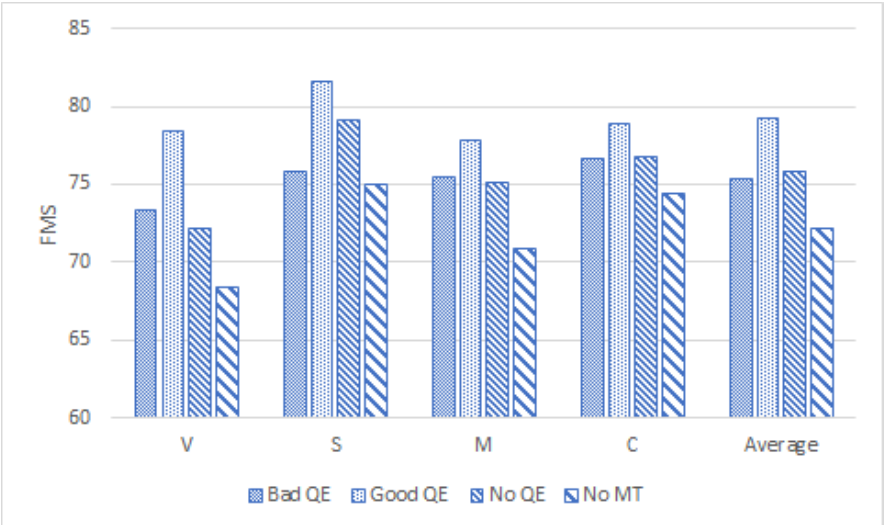
Figure 9. FMS scores for post-edited sentences compared to gold reference